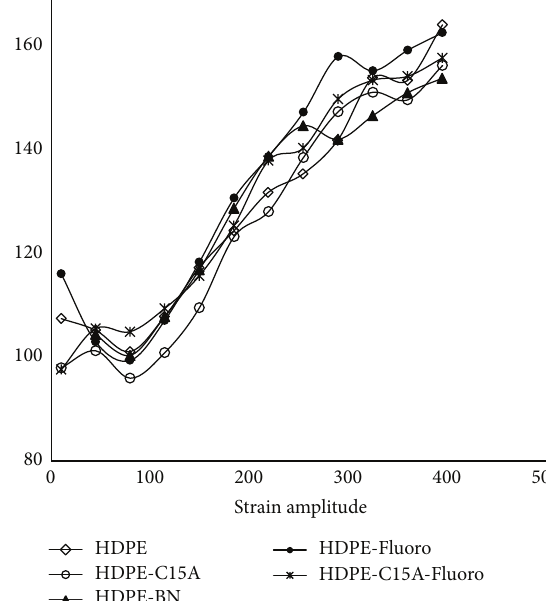
Figure 2: Van Gurp Palmen plot for HDPE, HDPE-C15A, HDPE- BN, HDPE-Fluoro, and HDPE-C15A-Fluoro.